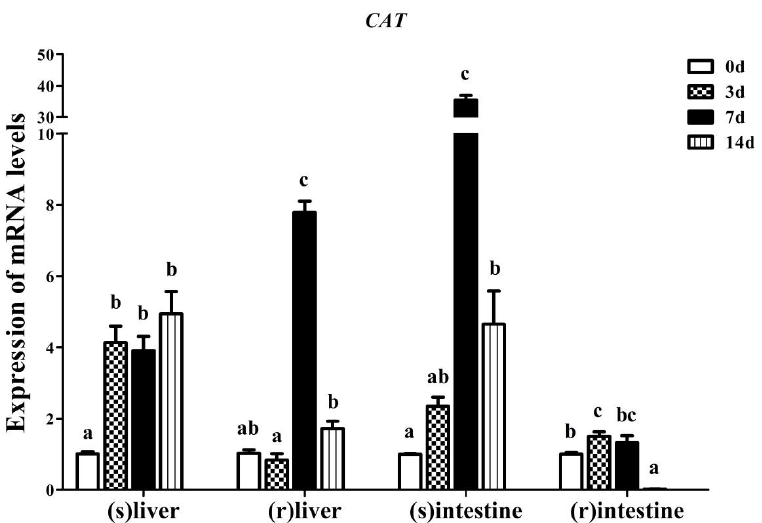
Figure 9. Relative expression of AdCAT in the intestine of Yangtze sturgeon during fasting and refeeding, s: starvation, r: refeeding. Data represent means ± SEM of six replicates. The different lowercase letters represent significant differences ( p < 0.05).